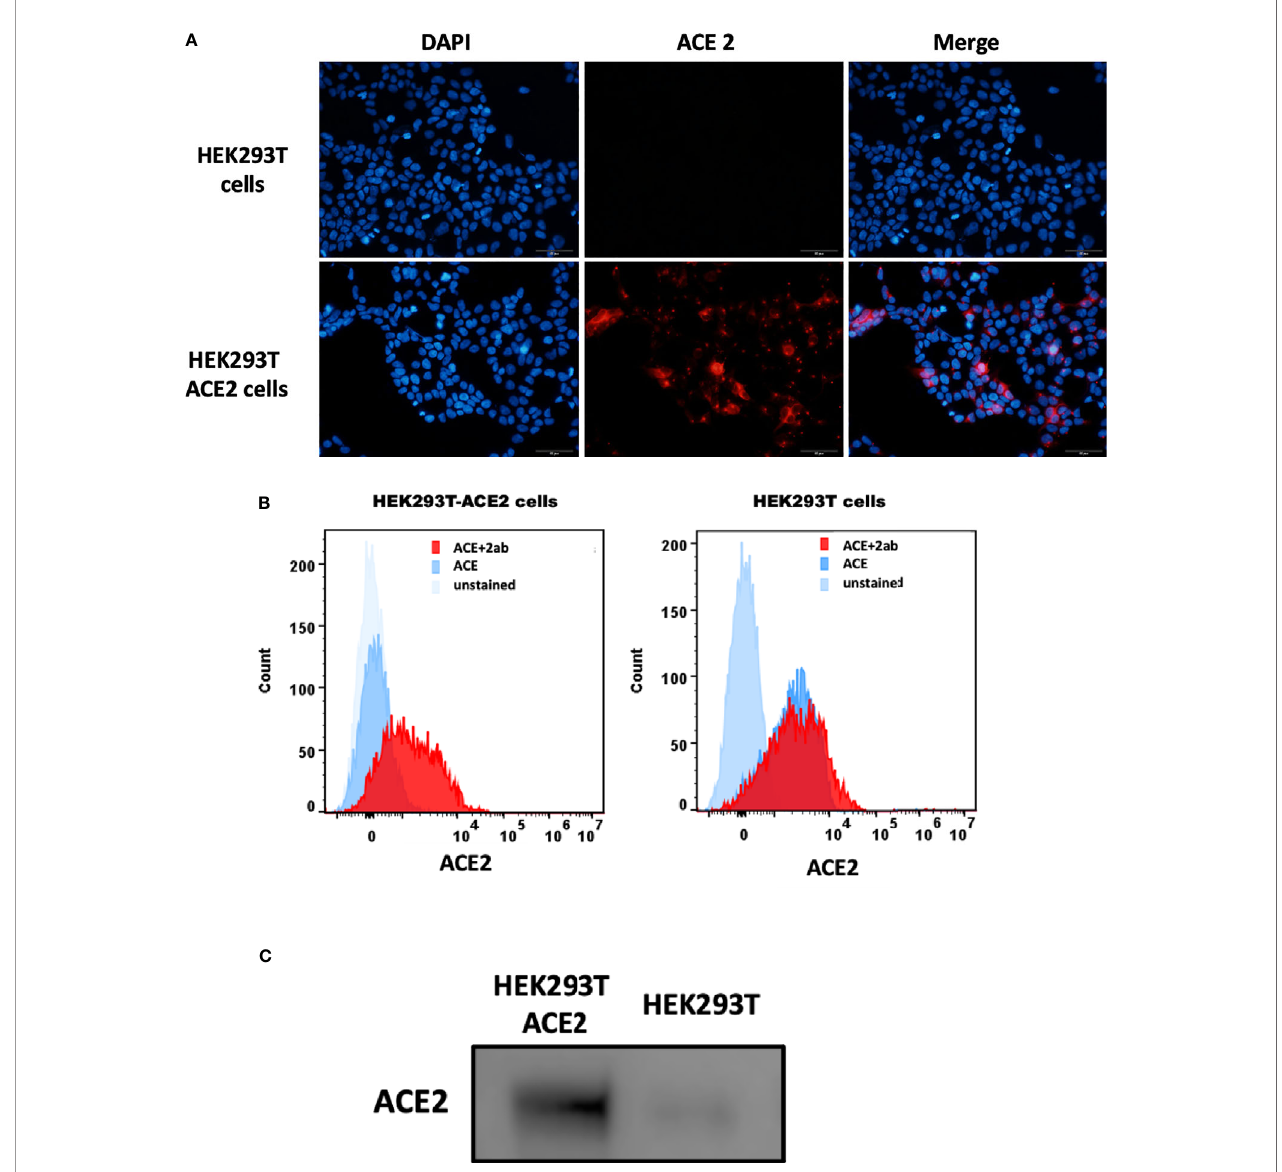
FIGURE 3 | Expression of ACE2 receptor on HEK293T cells by immuno fl uorescence microscopy (A) , fl ow cytometry (B) and western blotting (C) . (A) HEK293T (0.5x10 5 cells) and HEK293T-ACE2 cells (0.5x10 5 cells) were seeded on coverslips, followed by incubation at 37°C under standard culture conditions. After wasing the cells with PBS twice, the ACE2 expression was detected in both cell lines using the ACE2 antibody [SN0754](1:250), followed byincubation for 1 h at room temperature. Following PBS washes, Goat anti-rabbit IgG (H+L) cross-adsorbed secondary antibody (1:500) was added. Following PBS washes, the coverslips were mounted in medium with DAPI on a microscopy slide and viewed under a fl uorescence microscope (Olympus). (B) Flow cytometric analysis of ACE2 expression was determined by the shift in the fl uorescence intensity using ACE2 antibody [N1N2], N-term (GeneTex) (1:250). The ACE2 expression was detected by CytoFLEX. (C) The ACE2 expression was examined by western blotting using ACE2 antibody [SN0754] (GeneTex)